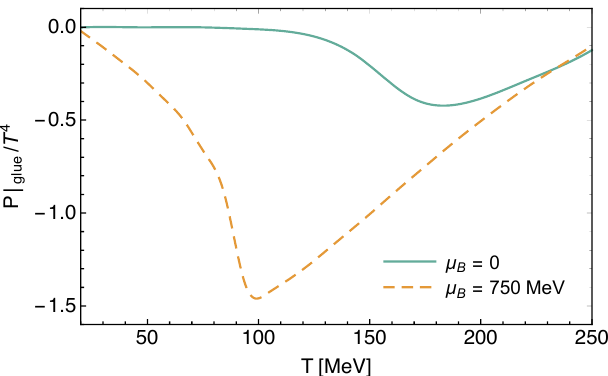
Figure 10: Contribution of the Polyakov loop potential to the pressure.